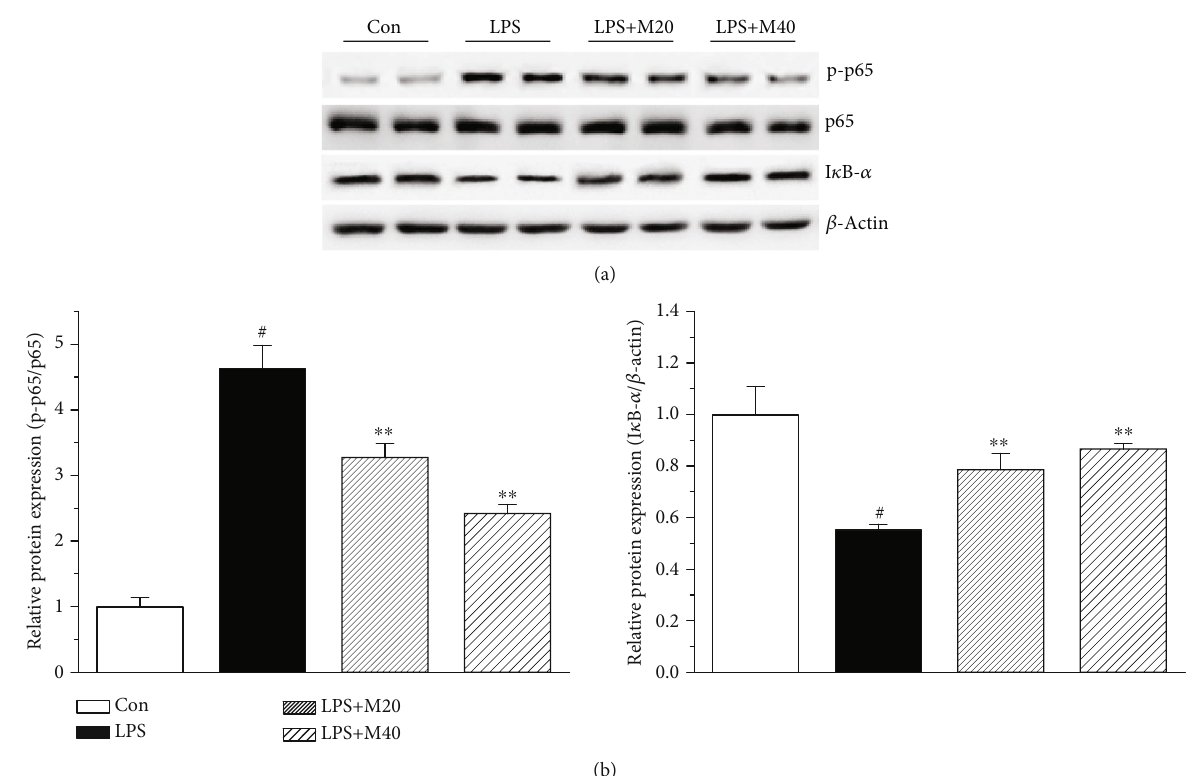
Figure 4: Mibefradil inhibited p65 phosphorylation and I κ B- α degradation in lung tissues of LPS-induced ALI mice. Mibefradil (40 mg/kg) was administrated 30min before LPS exposure. Mice were sacri fi ced 6 h after LPS exposure, and the whole protein extraction from lung tissues was processed. The phosphorylated p65 and I κ B- α expressions were measured by Western blotting, and the protein signals were quanti fi ed. All values are mean ± SEM ( n = 4 ). # p < 0 : 05 , compared with vehicle-treated control; ∗ p < 0 : 05 , signi fi cant compared with LPS alone; ∗∗ p < 0 : 01 , signi fi cant compared with LPS